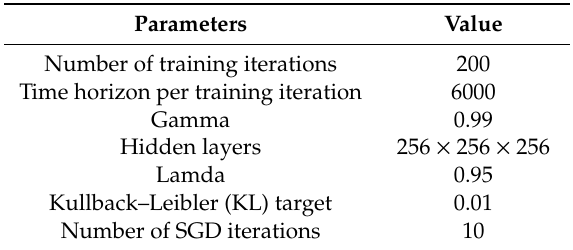
Table 2. Proximal policy optimization (PPO) hyperparameters for mixed-autonomy tra ffi c at a non-signalized